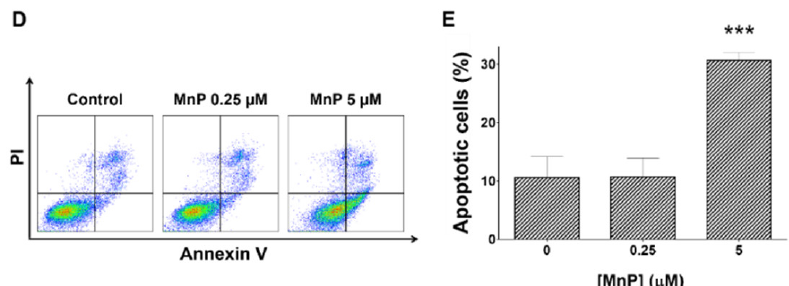
Figure 3. E ff ect of manganese porphyrin (MnP) on the cell cycle progression of 786-O cells. Cellular DNA content was analyzed by flow cytometry after 24 h incubation with MnP. ( A ) representative flow cytometry histograms. ( B ) sub-G1, G0 / G1, S, and G2 / M populations summary results. ( C ) sub-G1 population percentage. Percentage of apoptotic cells determined by PI and Annexin V staining ( D , E ) with representative flow cytometry dot-plots ( D ) and summary results show the percentage of apoptotic cells ( E ). Values represent mean ± SD (n = 3), *** p < 0.001 (Student’s t-test).